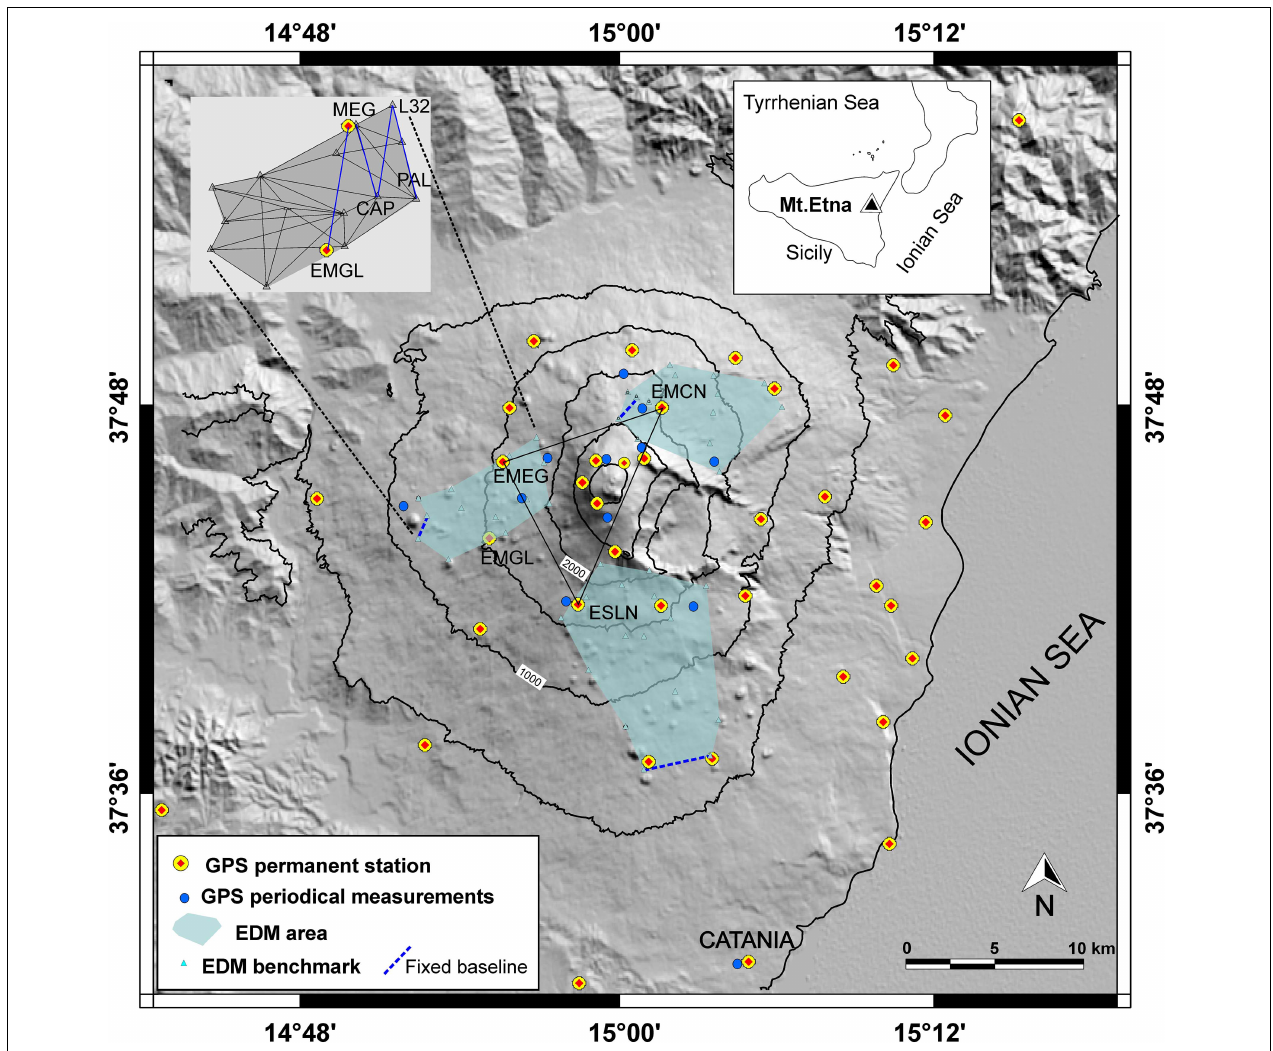
FIGURE 1 | Etna map with the different geodetic monitoring networks: the three networks covered by Electro-optical Distance Measurements (EDM), the GPS benchmarks periodically measured (blue circles) and the permanent stations of the continuous GPS (CGPS) (yellow-red circles).